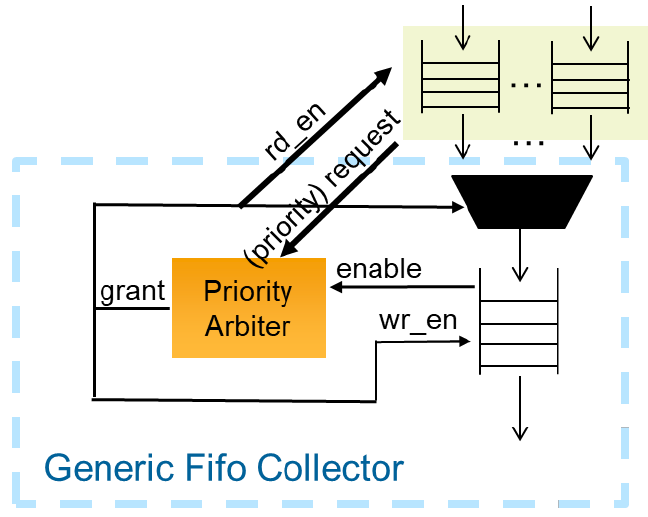
Figure 4. Connection of the priority